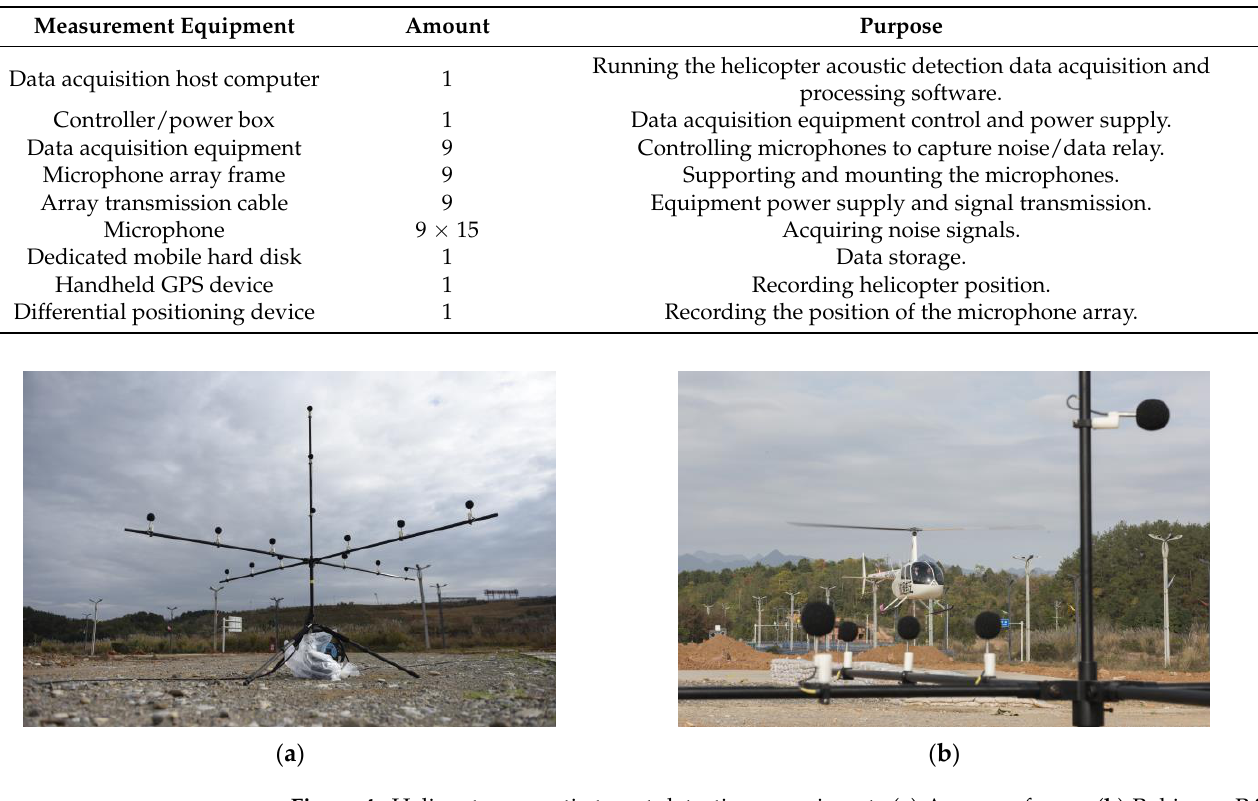
Figure 4. Helicopter acoustic target detection experiment. ( a ) An array frame; ( b ) Robinson R44 helicopter flight experiment site.